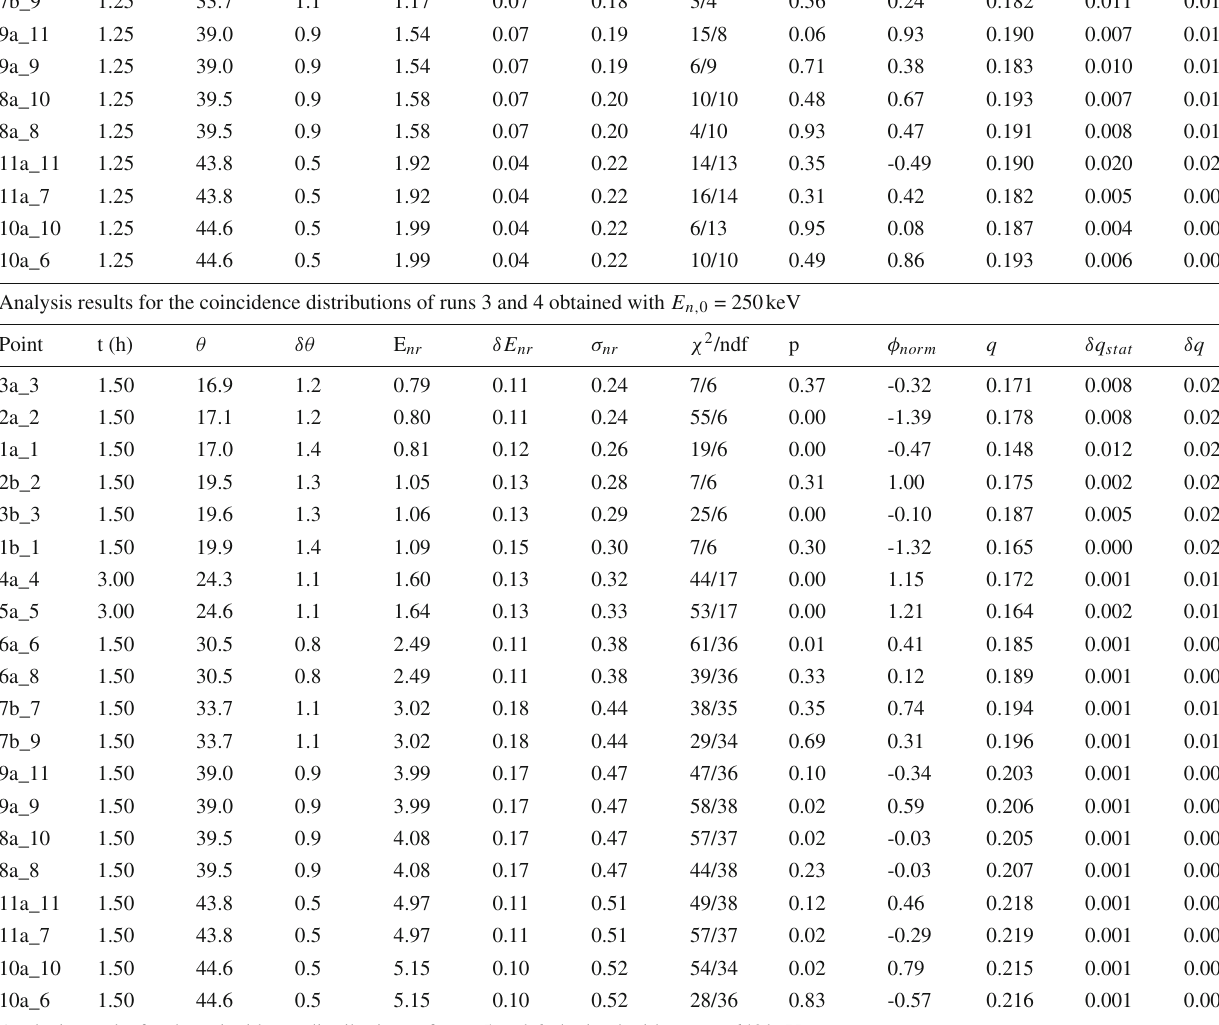
Table 5 Analysis results for the runs 3, 4 (a) and 5, 6 (b). For each point, the irradiation time t is indicated and the selected angle θ is given with its geometrical uncertainty δ θ . The corresponding selected mean nuclear recoil energy E nr , its uncertainty δ E nr and its width σ nr are obtained from a MC simulation of the setup. The χ 2 /ndf and p-values of the fit are reported along with the deviation Φ norm in sigma units of